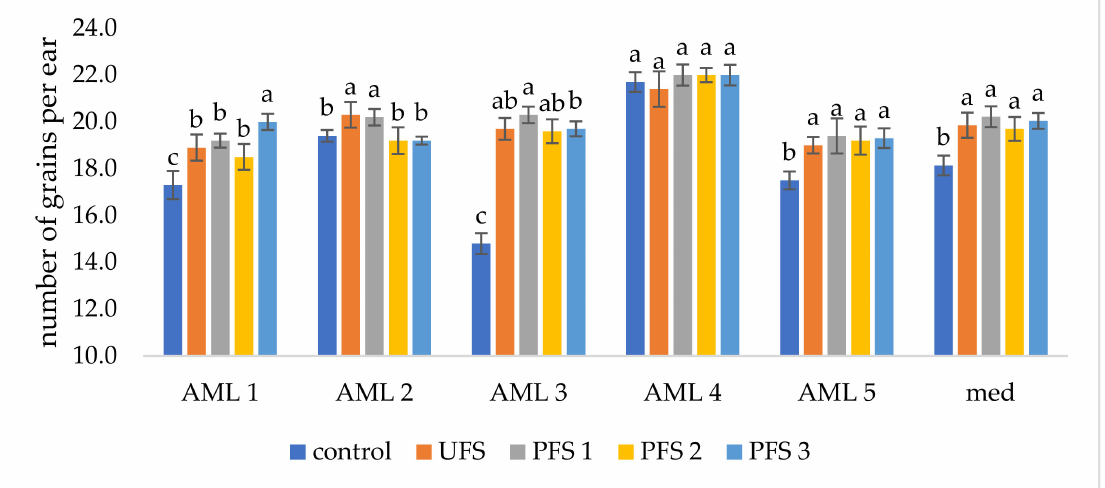
Figure 5. The number of grains per ear of winter wheat in the experiment. The different letters repre- sent statistically significant ( p ≤ 0.05) differences between the tested options of fertilizer application. Error bars show the standard deviation of the mean value ( n = 15). AML 1 is the eluvial agricul- tural microlandscape, AML 2 is the eluvial-accumulative agricultural microlandscape, AML 3 is the transit-eluvial agricultural microlandscape, AML 4 is the accumulative agricultural microlandscape, AML 5 is the accumulative agricultural microlandscape. Control is the option without fertilizers, UFS is the uniform application of organic and mineral fertilizers, PFS 1 is the differentiated application of organic and uniform application of mineral fertilizers, PFS 2 is the differentiated application of mineral and uniform application of organic fertilizers, PFS 3 is the differential application organic and mineral